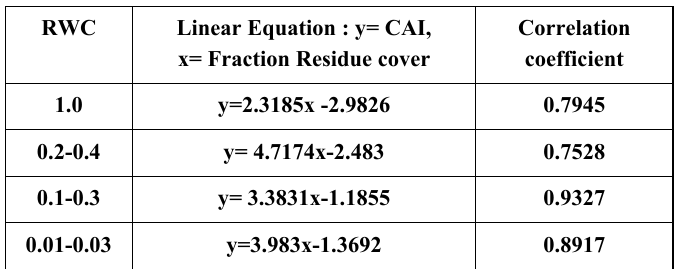
Figure 5 Rice residue cover plotted as a function of CAI for water content ranging from saturated to